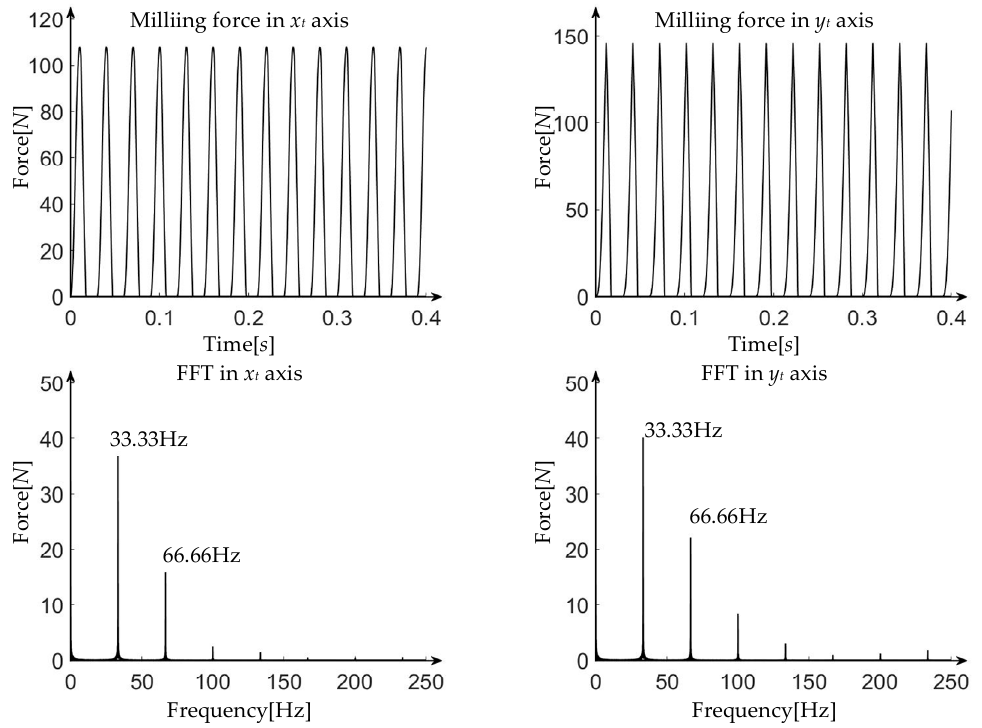
Figure 6. The milling force and its Fast Fourier Transform (FFT).